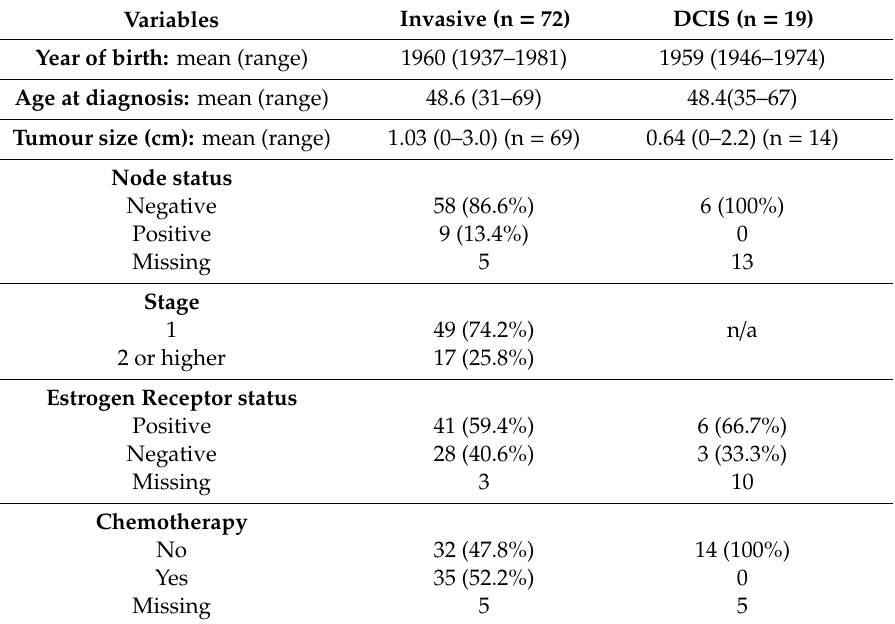
Table 2. Characteristics of the 92 incident breast cancers by cancer